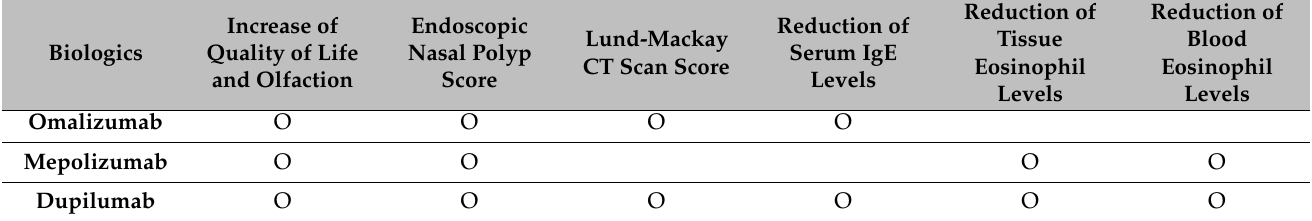
Table 4. Effects of biologics on